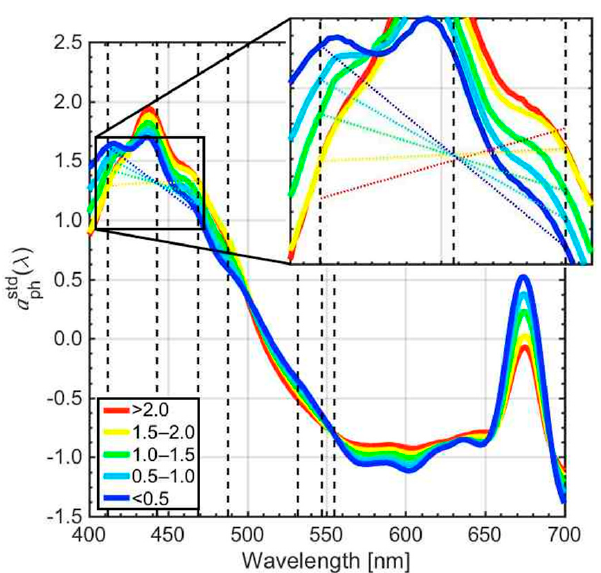
Figure 3. The relationship between a std ( λ ) spectra and CSD slope. Colored solid lines represent average a std ( λ ) for each range of CSD slope values; cool colors indicate larger size structure of phytoplankton, while warm colors indicate smaller size structure of phytoplankton. Black dashed lines represent the 7 MODIS bands between 412 and 555 nm, colored dotted lines indicate simple connecting lines between a std ( λ ) at 412 and 469 nm for each range of CSD slope values.